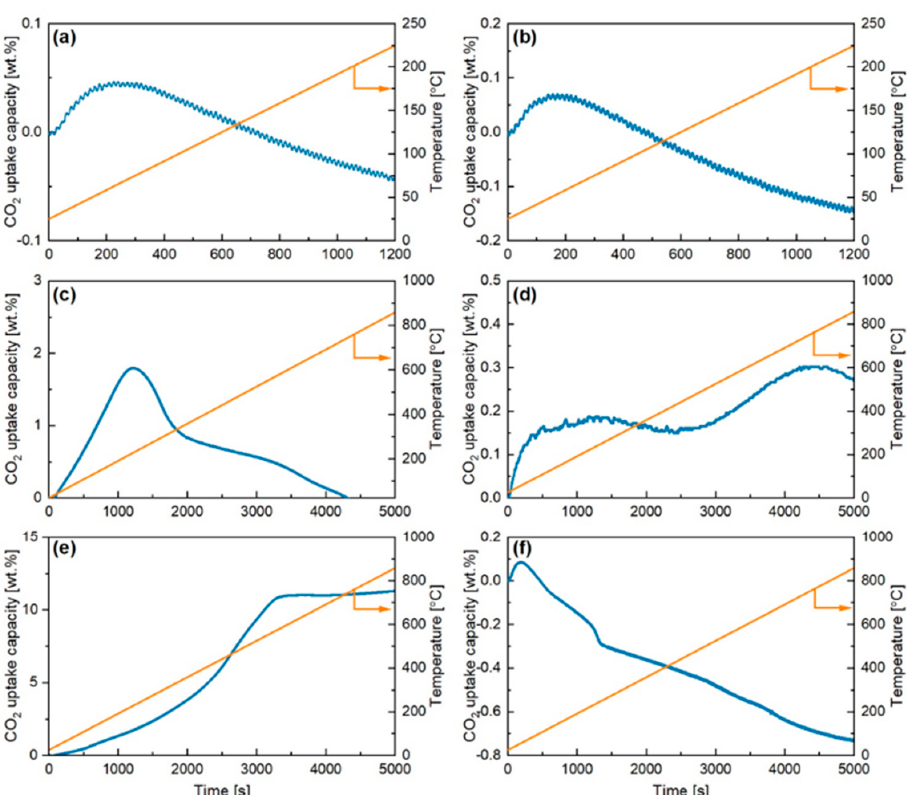
Figure 1. CO 2 dynamic adsorption for the different commercial sorbents. ( a ) ZrO 2 ; ( b ) SnO 2 ; ( c ) Na 2 SnO 3 ; ( d ) Ca 2 SnO 3 ; ( e ) K 2 SnO 3 ; ( f ) Li 2 SnO 3 .